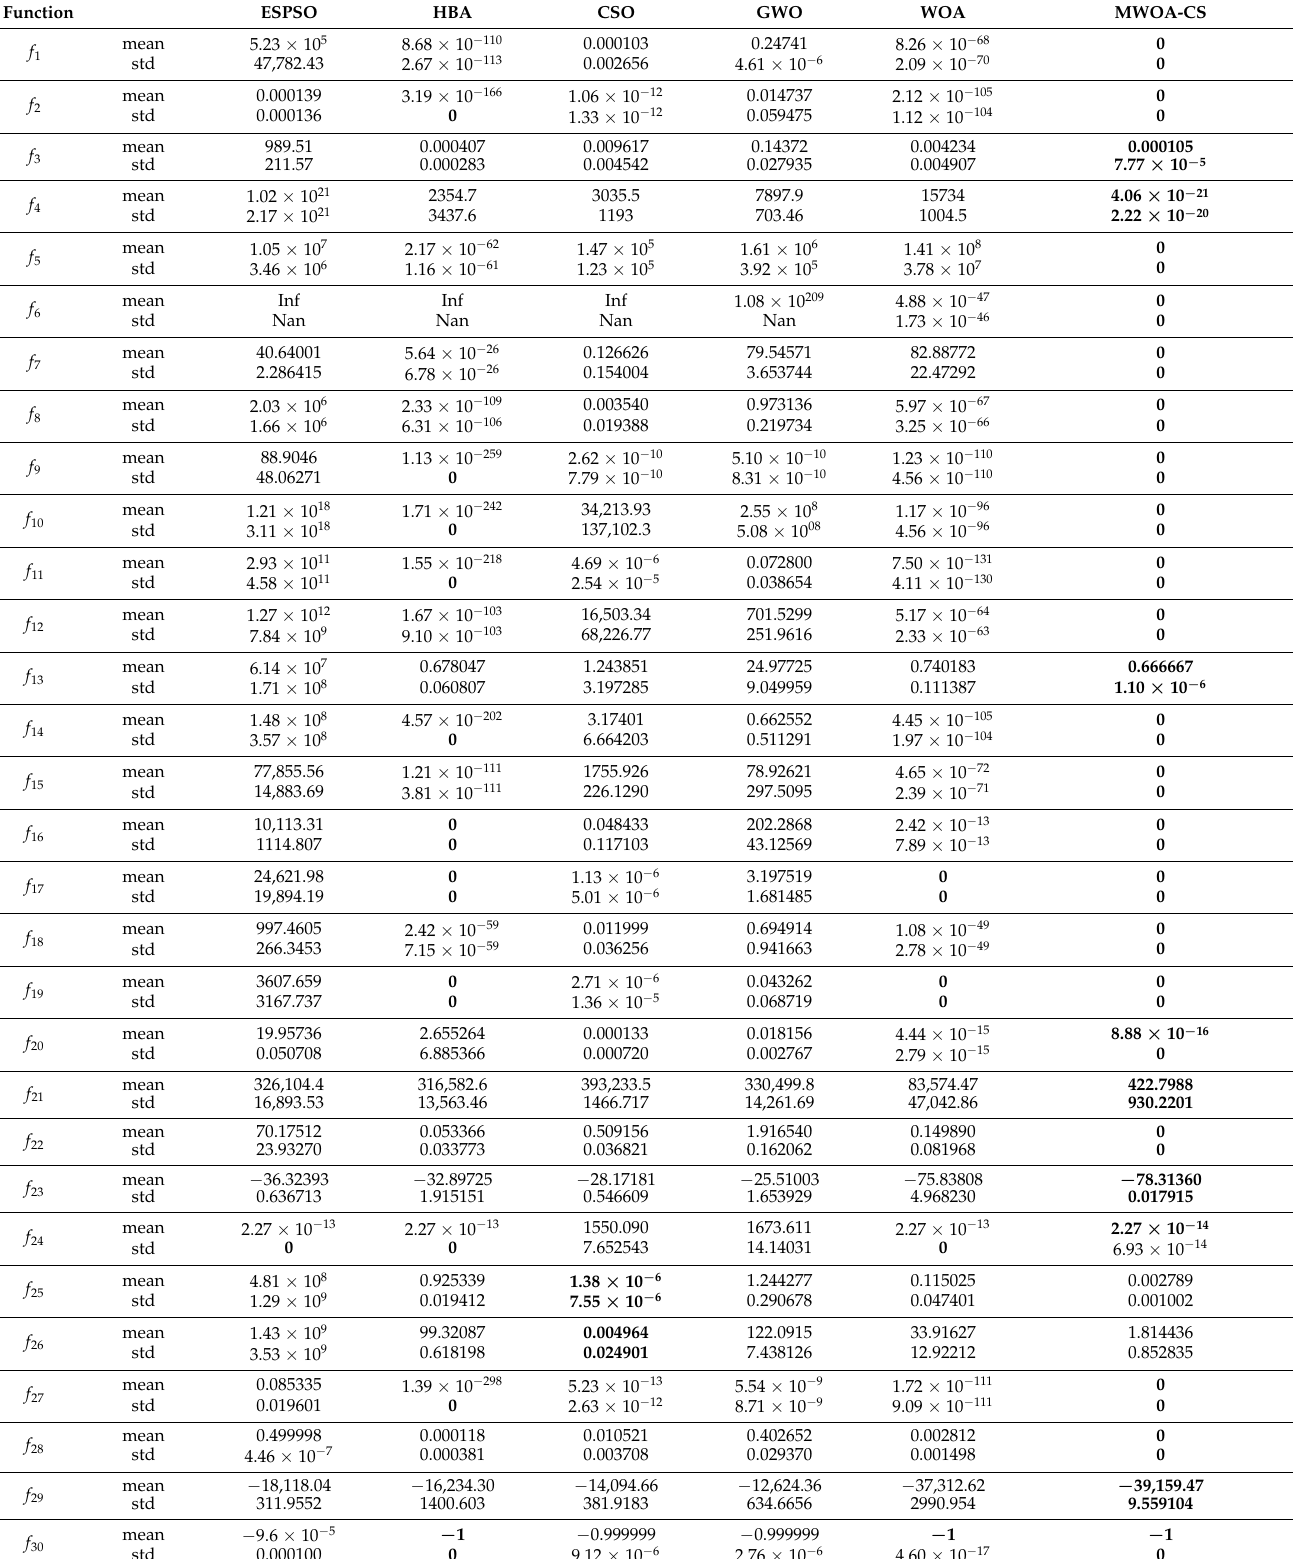
Table 5. Comparison results of algorithms for test problems with dim =